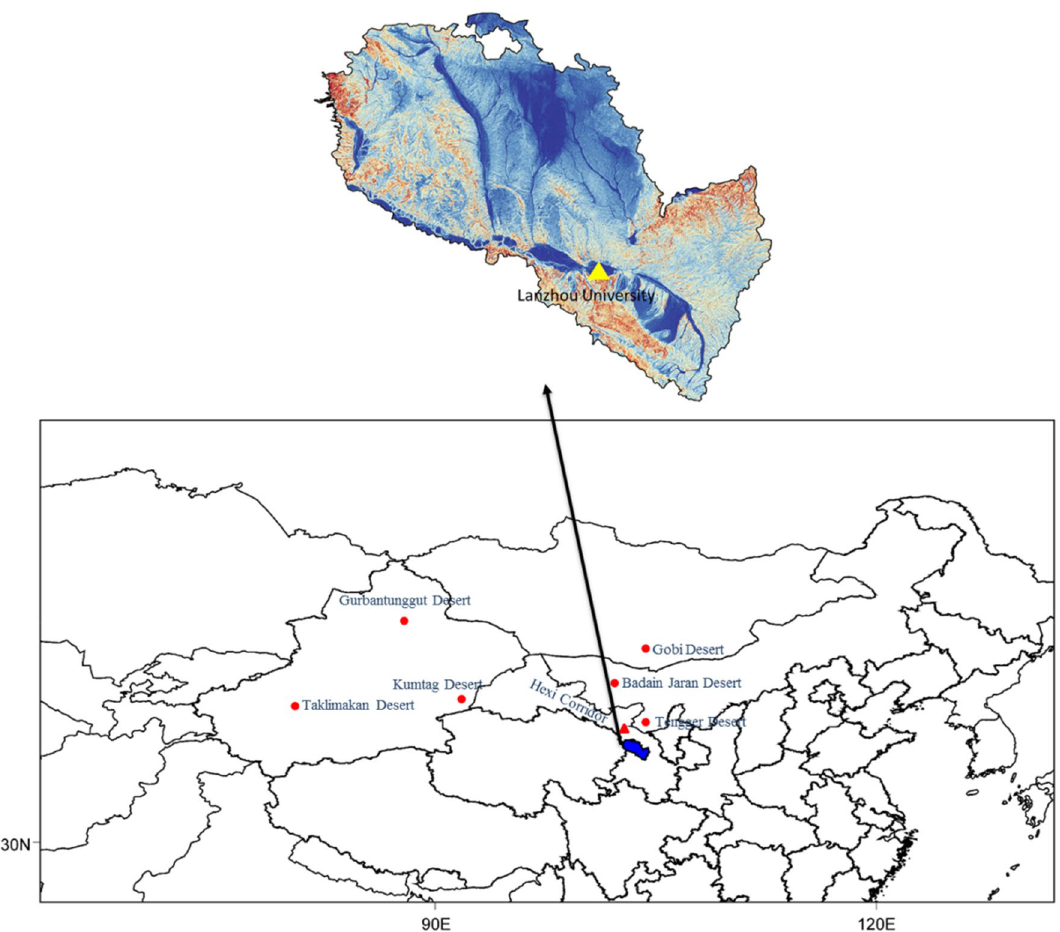
Figure 1. Location of sampling site (The statellite imagery was created on ArcGIS 10.3 platform (http:// www. esri. com/ softw are/ arcgis/ arcgis- for- deskt op) and the map of Asia was created by MeteoInfo 3.1.7 (http:// www. meteo think. org/ downl oads/ index.